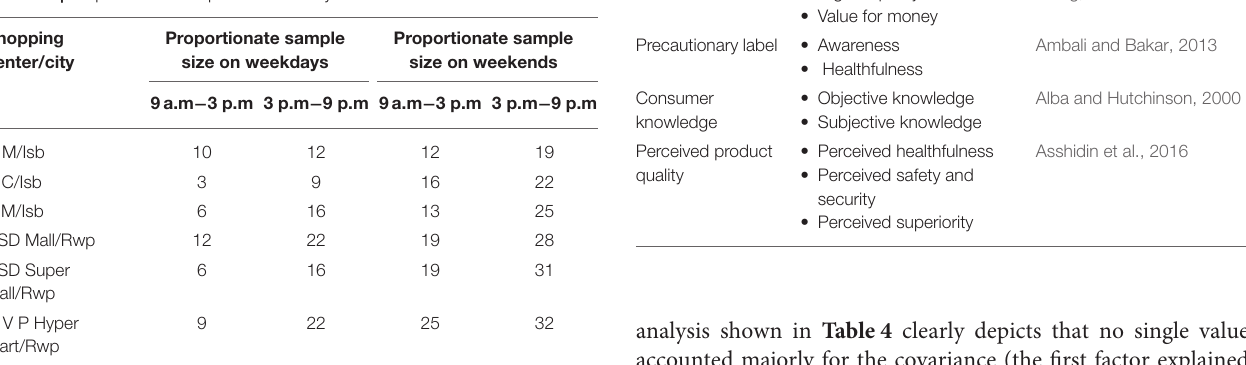
TABLE 2 | Proportionate sample time and day wise.